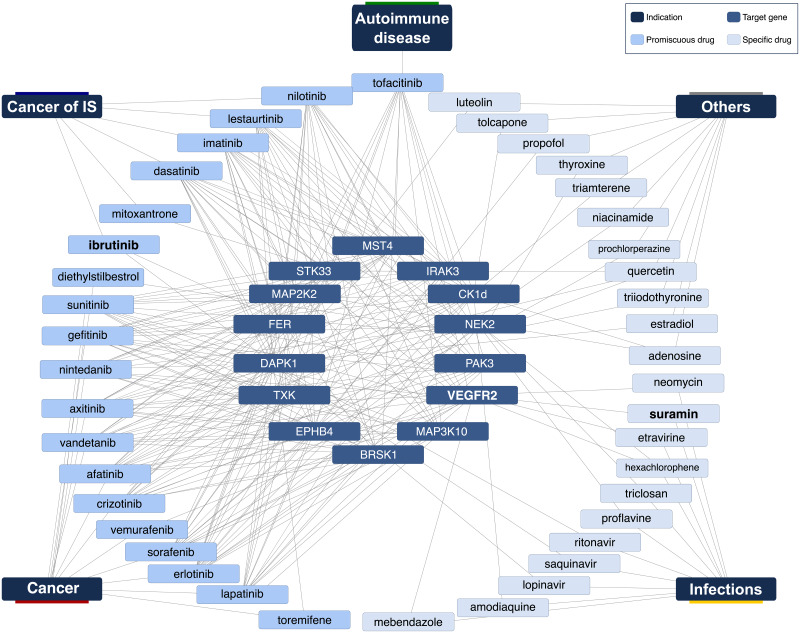
Drug-target-disease network.Inner circle (14 targets), mid circle (known and predicted inhibitors), outer circle (diseases). There is a tight network of cancer drugs and targets while there is only one known autoimmune compound, which binds, however, many of the cancer targets. VEGR2, the promising autoimmune target, we identified, is inhibited by cancer and anti-infection drugs.